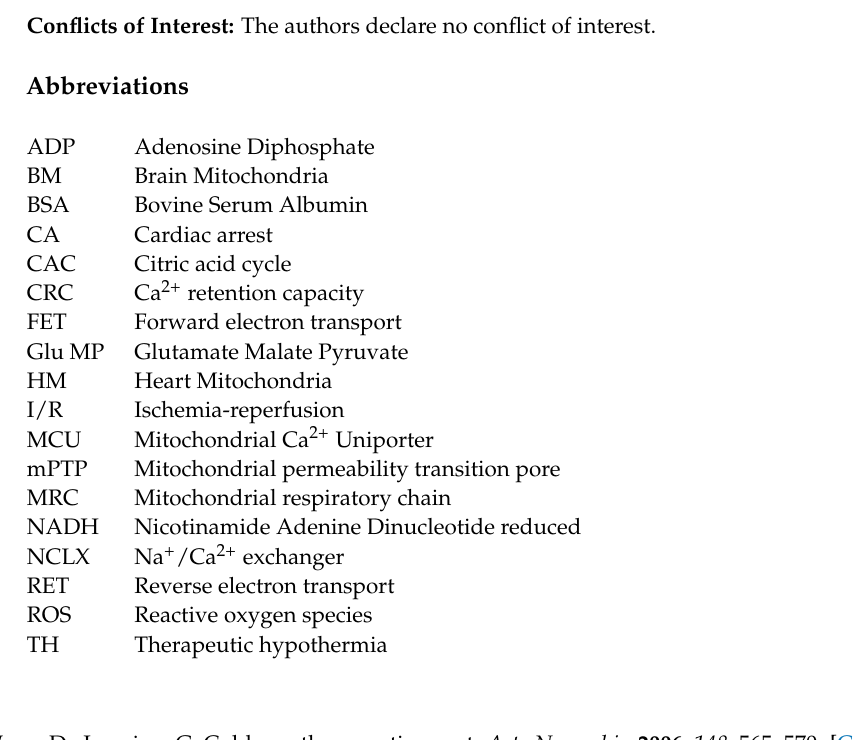
Figure S5. True CRC calculation, calibration and Q10 coefficients. Figure S6. Calibration of TMRM fluorescence assay to estimate change in mitochondrial membrane potential ( Ψ